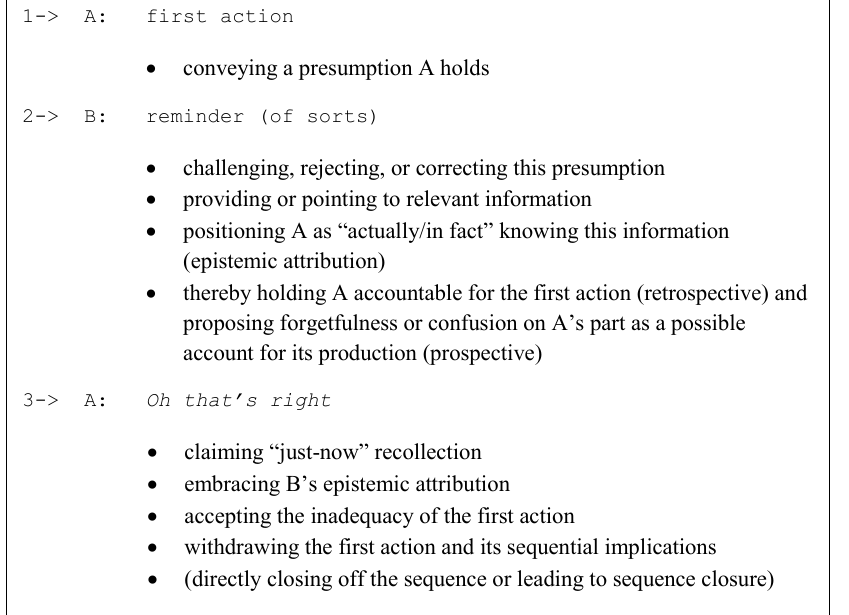
Figure 1. Schematic representation of the prototypical sequential organization of oh that’s right sequences and key properties of each turn in the sequence (elements in Courier New font with numbered arrows represent the three turns, elements in Times New Roman following bullet points summarize central features of these turns)